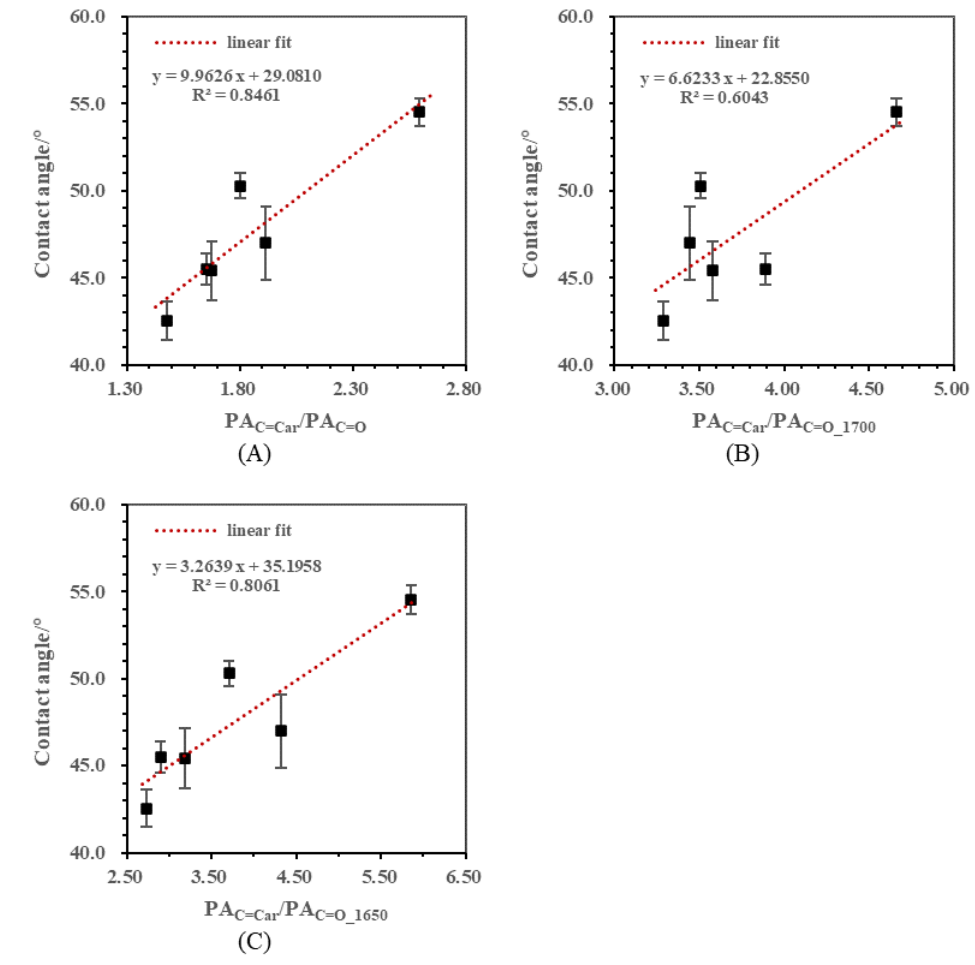
Figure 5. Correlations between contact angles and aromatic semi-quantitative ratios. ( A ) Correlation between contact angle and PA C=Car /PA C=O ; ( B ) Correlation between contact angle and PA C=Car /PA C=O_1700 ; ( C ) Correlation between contact angle and PA C=Car /PA C=O_1650 .